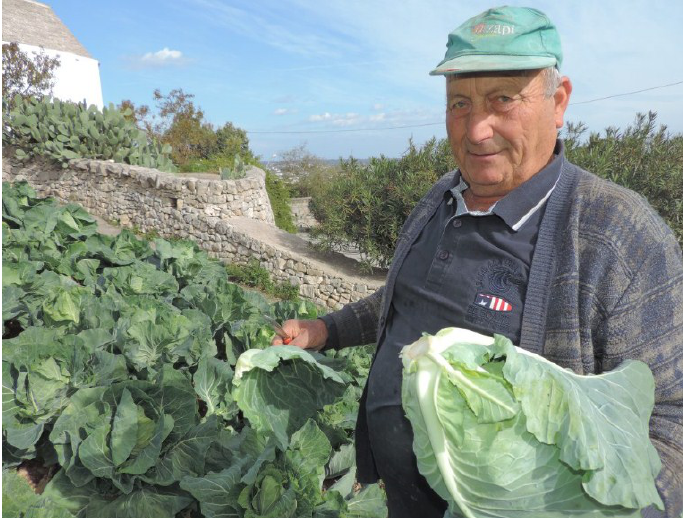
Figure 13. An example of old farmer (Raffaele Cristoforo) who acts as a seed saver of the “Verza a cuore di bue”, a local variety of cabbage ( Brassica oleracea L. var. capitata [L.] DC.) (Photo credit: